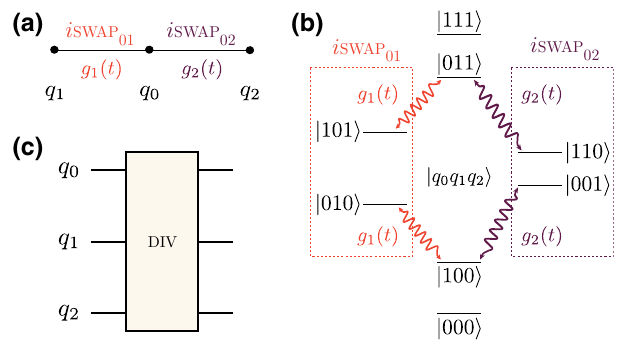
FIG. 12. Setup and operation for the three-qubit gate realized through simultaneous application of two i SWAP gates. (a) The setup considered is a linear chain of three qubits with nearest- neighbor coupling. The i SWAP gates i SWAP 0 j between qubits 0 and j = { 1, 2 } are applied simultaneously by activating couplings between the | 1 0 0 j (cid:2) and | 0 0 1 j (cid:2) states with coupling strength g j . (b) The transitions in the three-qubit system activated by the application of the i SWAP gates. The states | 000 (cid:2) and | 111 (cid:2) are not affected by the gates. (c) We denote the three-qubit opera- tion resulting from the simultaneous application of the two i SWAP gates by DIV , since it is a “divider” gate that can distribute one or two excitations among all three